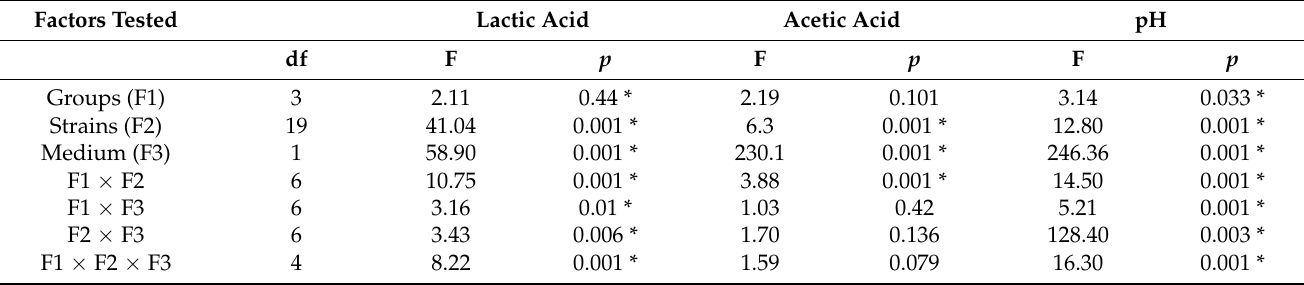
Table 4. Physicochemical parameters of media inoculated with L. plantarum strains (ANOVA, Factorial design, Post Hoc Tukey’s HSD Test, Statistica v.12.0). Factors (F1, F2, F3) are represented by four groups of lactobacilli origin (F1), twenty strains of lactobacilli (F2), both summarised in Table 1, and three types of the cultivation media (F3) (MRS, MRS + FGGM, milk). The asterisk indicates significant differences. * Significant at α ≥